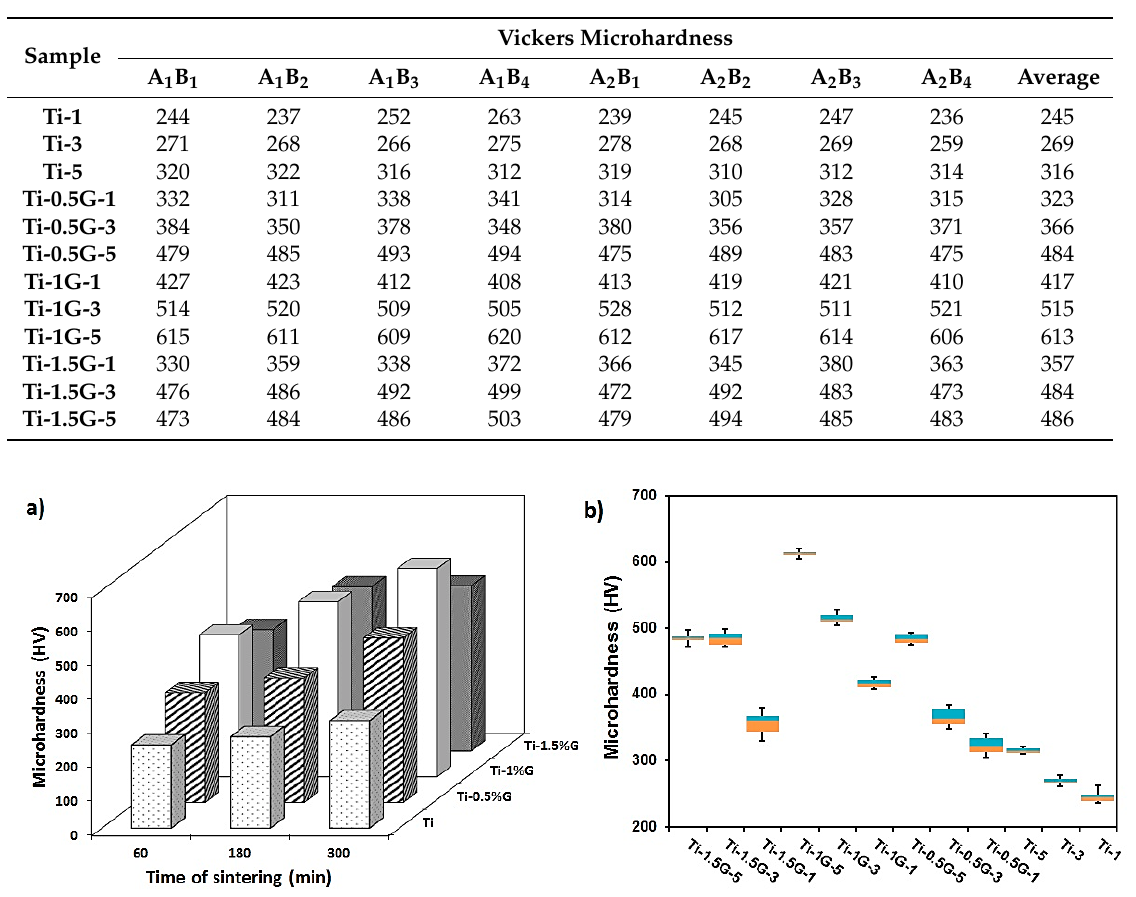
Table 2. The Results of the Vickers microhardness test for the specified sections in composites produced in different conditions.